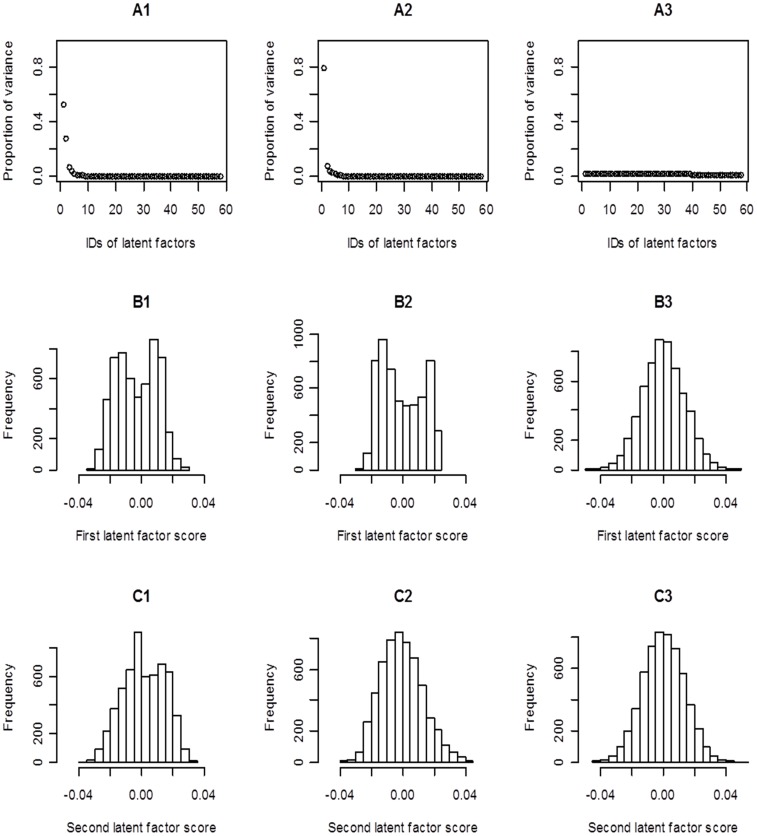
The singular value decomposition (SVD) analysis of miRNA-mRNA transcriptional correlation matrices.Before the decomposition, Pearson correlation coefficients were transformed with Fisher’s r-z method. A1/B1/C1: the results obtained from the primary prostate cancer (PPC) samples. A2/B2/C2: the results obtained from the metastatic prostate cancer (MPC) samples. A3/B3/C3: the results obtained from a random data structure generated by shuffling the PPC matrix.